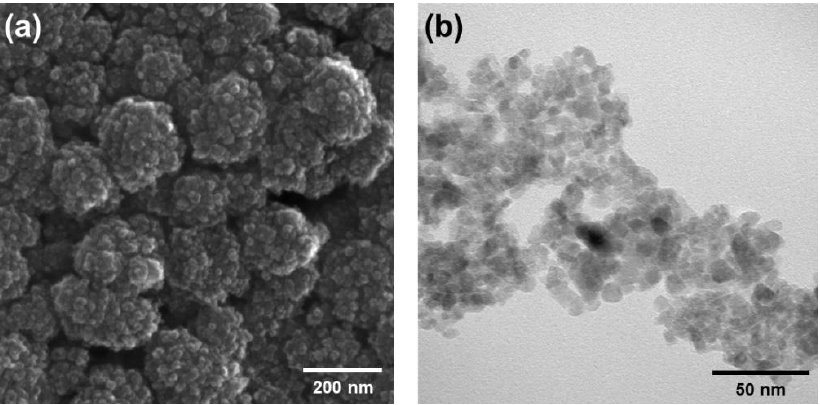
Figure 5. The results of SEM ( a ) and TEM ( b ) analysis for titanium dioxide. Based on the SEM and TEM images, for reference TiO 2 sample (Figure 5a,b), shows